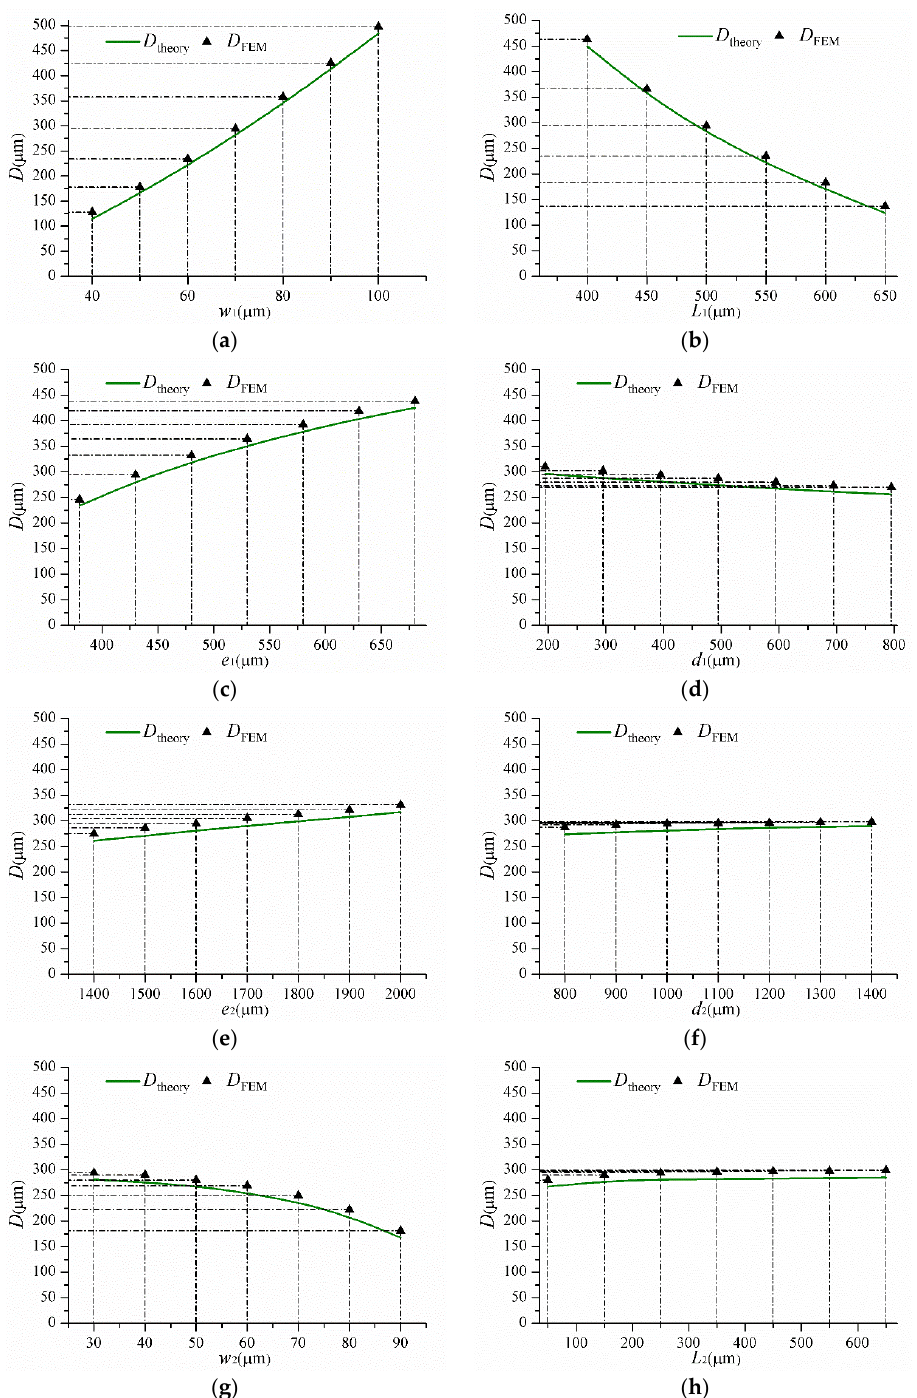
Figure 4. The effects of different geometrical parameters on D. ( a ) The effect of w 1 ; ( b ) The effect of L 1 ; ( c ) The effect of e 1 ; ( d ) The effect of d 1 ; ( e ) The effect of e 2 ; ( f ) The effect of d 2 ; ( g ) The effect of w 2